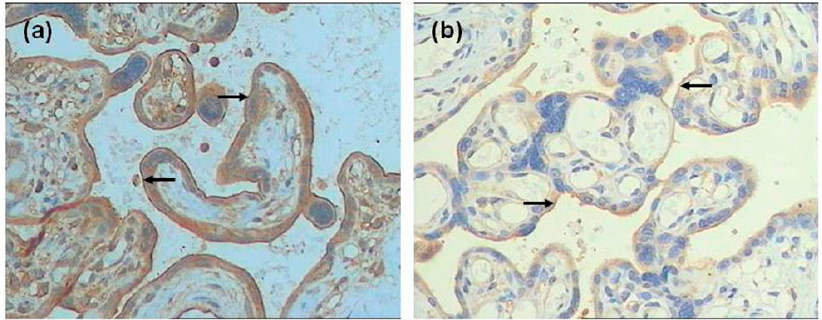
Figure 1 . Cont . Figure 1. Cont